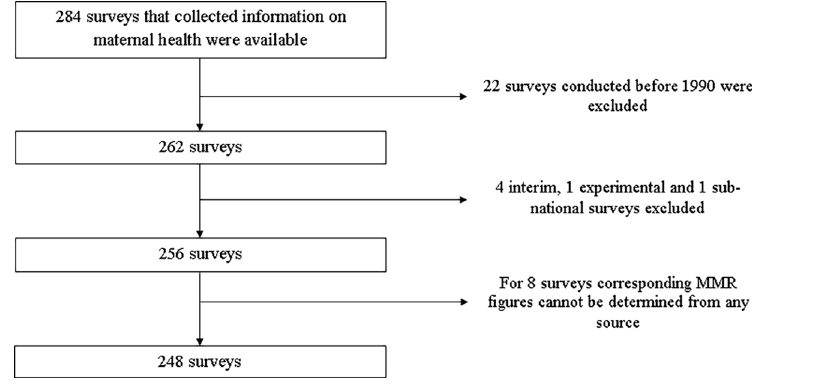
Fig 1. Flow chart of the study.